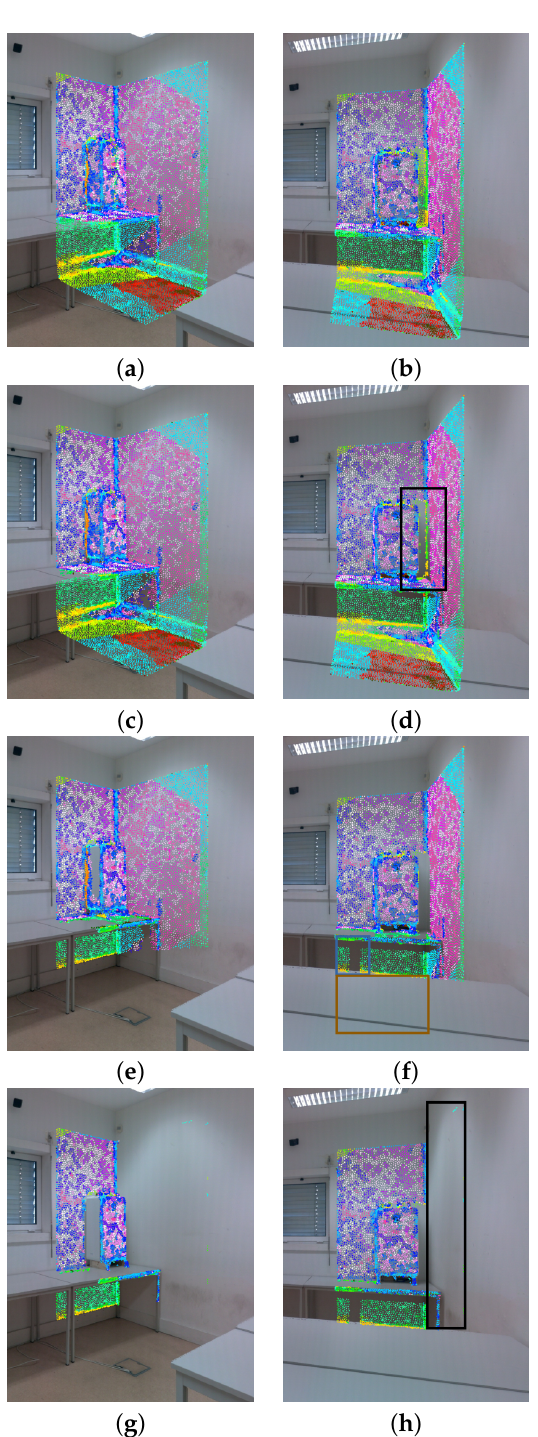
Figure 4. Pairwise mappings filtering procedure: ( a , b ) pairwise mappings with no filter applied; ( c , d ) pairwise mappings with z-buffering applied; ( e , f ) pairwise mappings with z-buffering filter and depth consistency applied; and ( g , h ) pairwise mappings with the entire filtering procedure